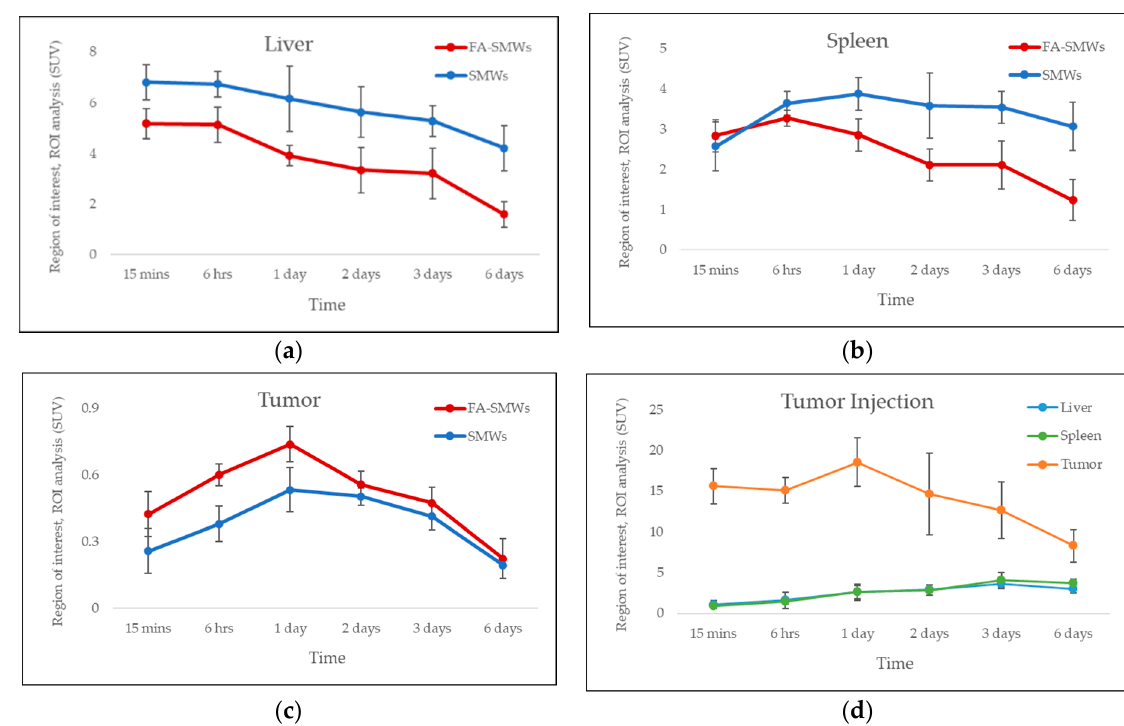
Figure 10. Region of interest (ROI) analysis of PET studies. Standard uptake value of ( a ) liver, ( b ) spleen, and ( c ) tumor for 89 Zr-FA-SMWs (FA-SMWs, red) and 89 Zr-SMWs (SMWs, blue). Standard uptake value ( d ) tumor site injection of 89 Zr-FA-SMWs (n = 3).